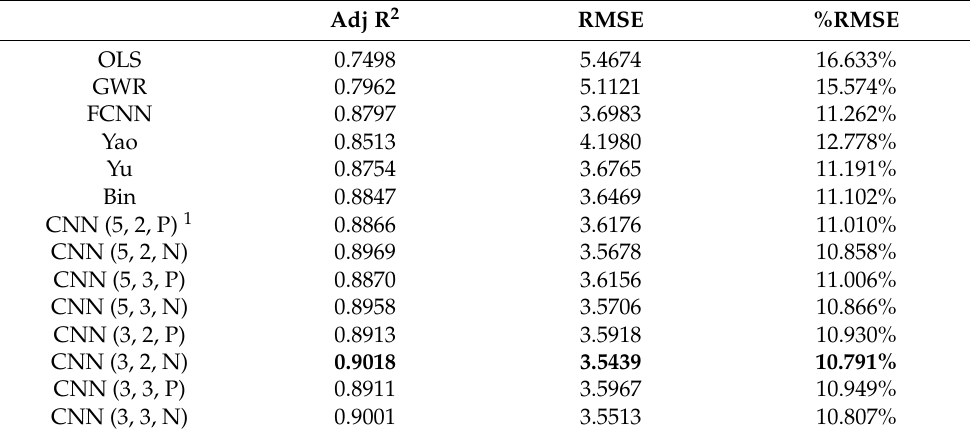
Figure 6. Parameters observed during the training processes of the: ( a ) FCNN model, and ( b ) CNN model (for an average group). Table 3. Results of 1-dimensional and 2-dimensional models.